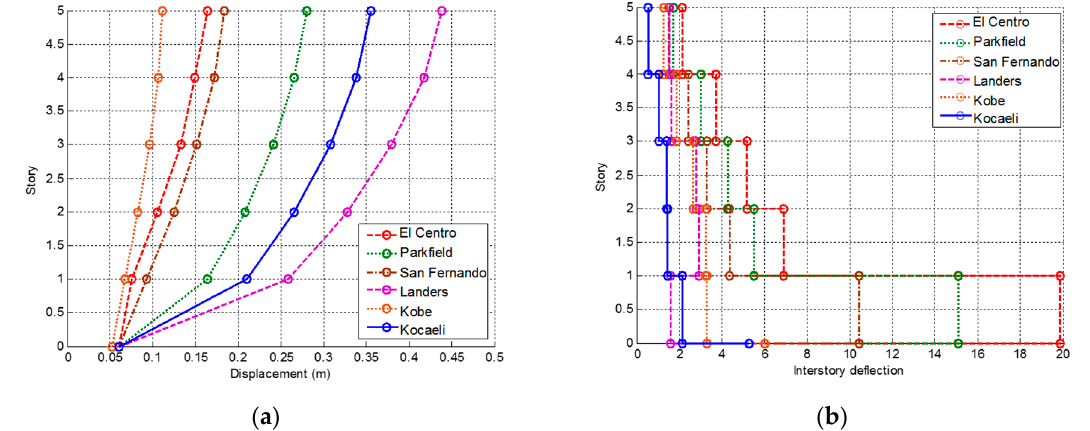
Figure 16. The results of ( a ) peak displacement and ( b ) peak interstory deflection for different stories of isolated buildings with rubber bumpers.